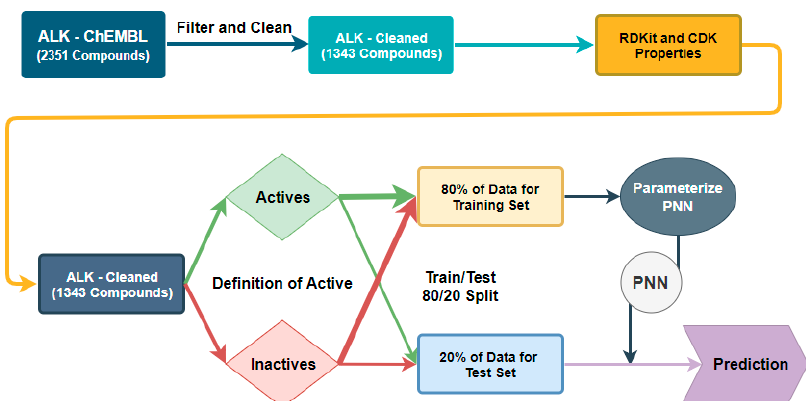
Figure 3. Workflow for classification threshold evaluation in the Probabilistic Neural Network (PNN) algorithm.